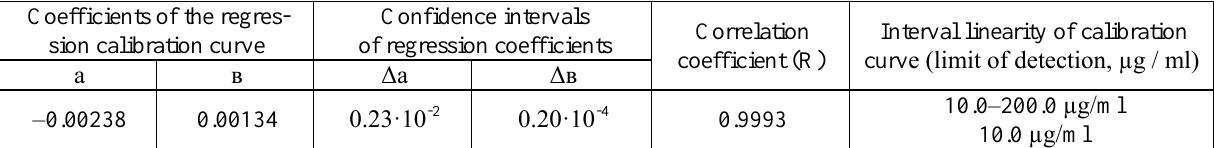
Fig. 2. Calibration graph of quantitative determination of prazosin hydrochloride by HPLC method Coefficients of the regression calibration curve S=вC+а of quantitative determination of prazosin hydrochloride by HPLC method (n=9, P=95